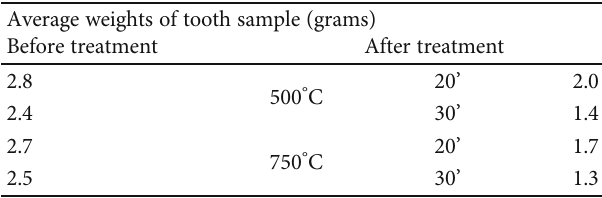
Table 1: Average weights of the tooth samples before and after the treatment (high-temperature exposure).